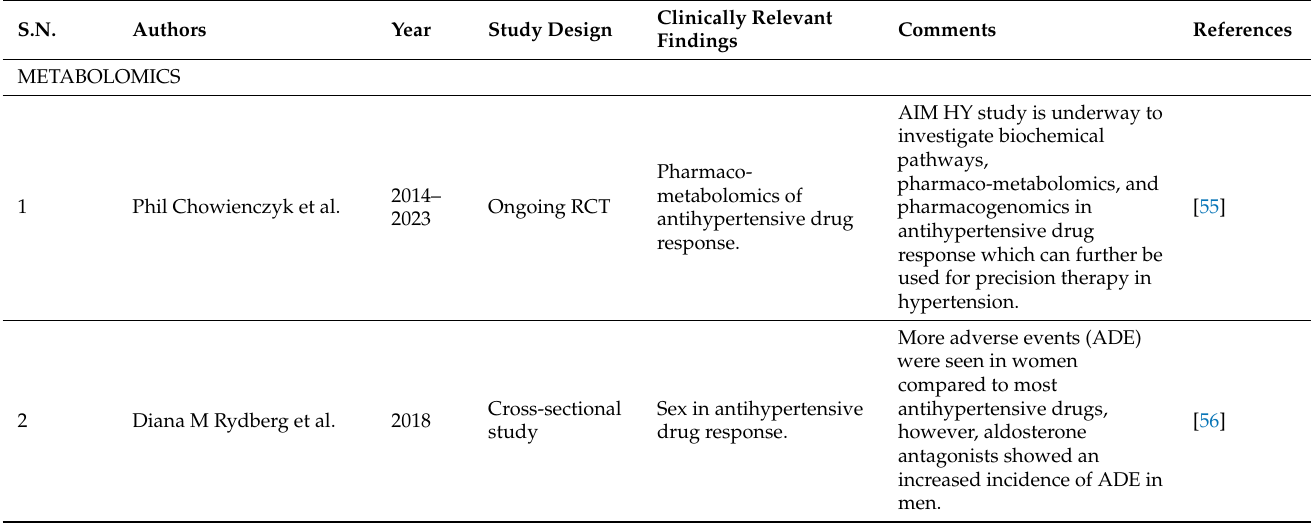
Table 3. A compilation of the literature underlining role of precision medicine in